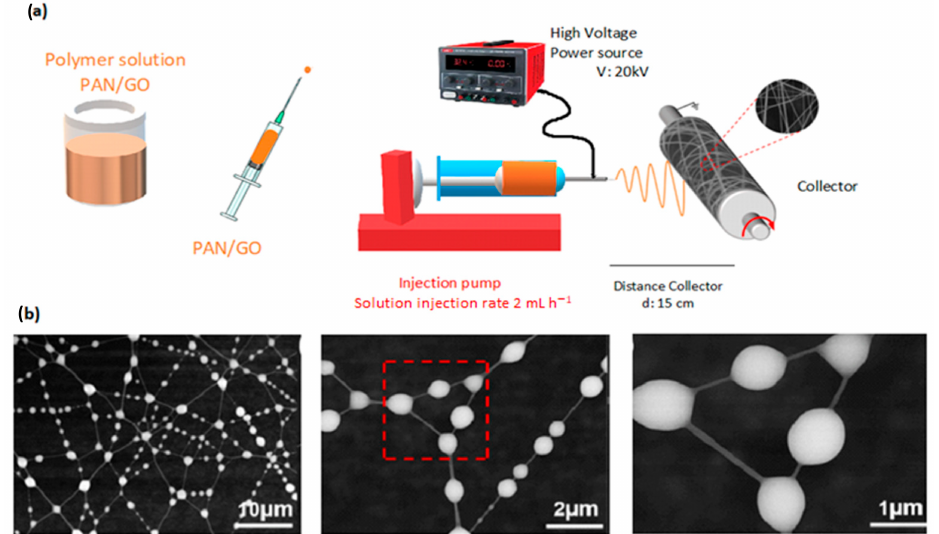
Figure 15. ( a ) Process for obtaining electrospun fiber (PAN/GO) in solution. ( b ) SEM images of the PAN/GO nanofibers after PM 2,5 adsorption. Reprinted with permission from Ref.